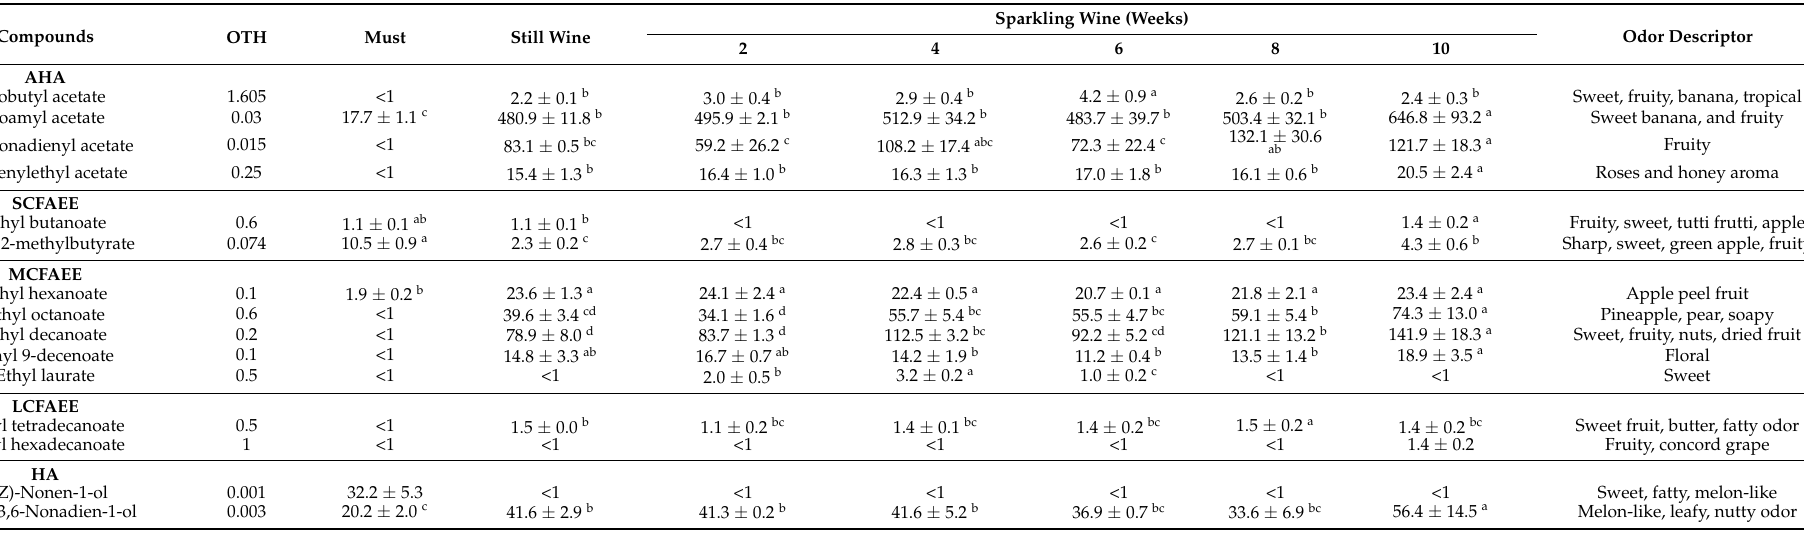
Table 7. Evolution of principal odor activity value (OAV > 1) in enriched must, still wine, and during the sparkling process of melon-based wine (10